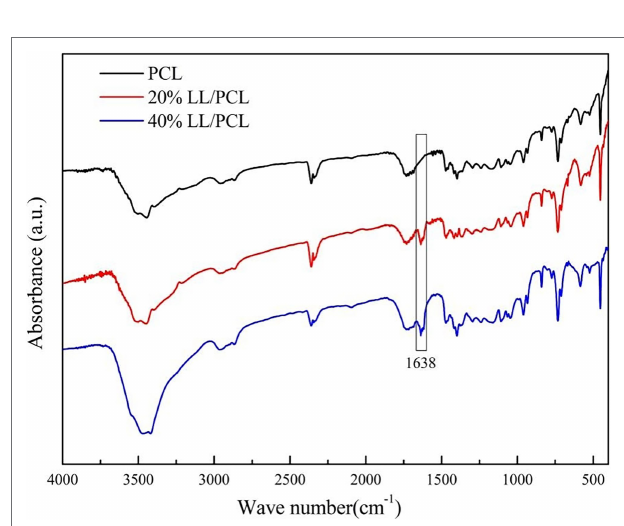
FIGURE 2 | FT-IR patterns of LL/PCL fibrous